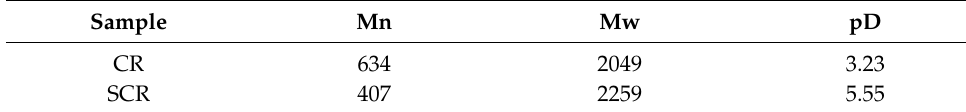
Figure 13. Molecular weight distribution of CR and SCR. Table 7. Mn, Mw, and pD of CR and SCR.